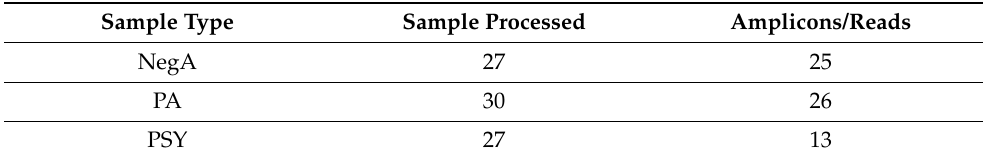
Table 1. Groupwise amplification of reads.